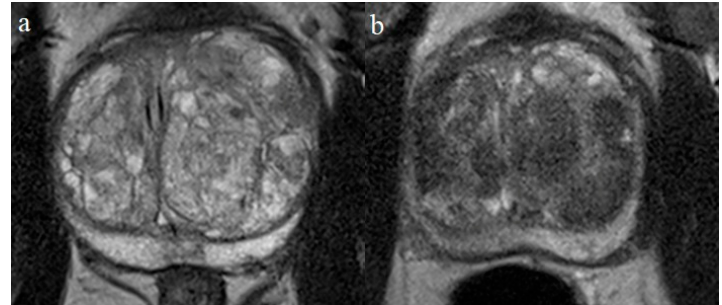
Figure 2. ( a ) Benign prostatic hyperplasia in a patient demonstrated on magnetic resonance imaging with T2-weighted turbo spin echo sequence in the transversal plane. Notice the adenoma in the left lobe compressing the prostatic urethra; ( b ) the same patient three months after treatment with a reduced T2 signal corresponding to infarction of the adenoma.